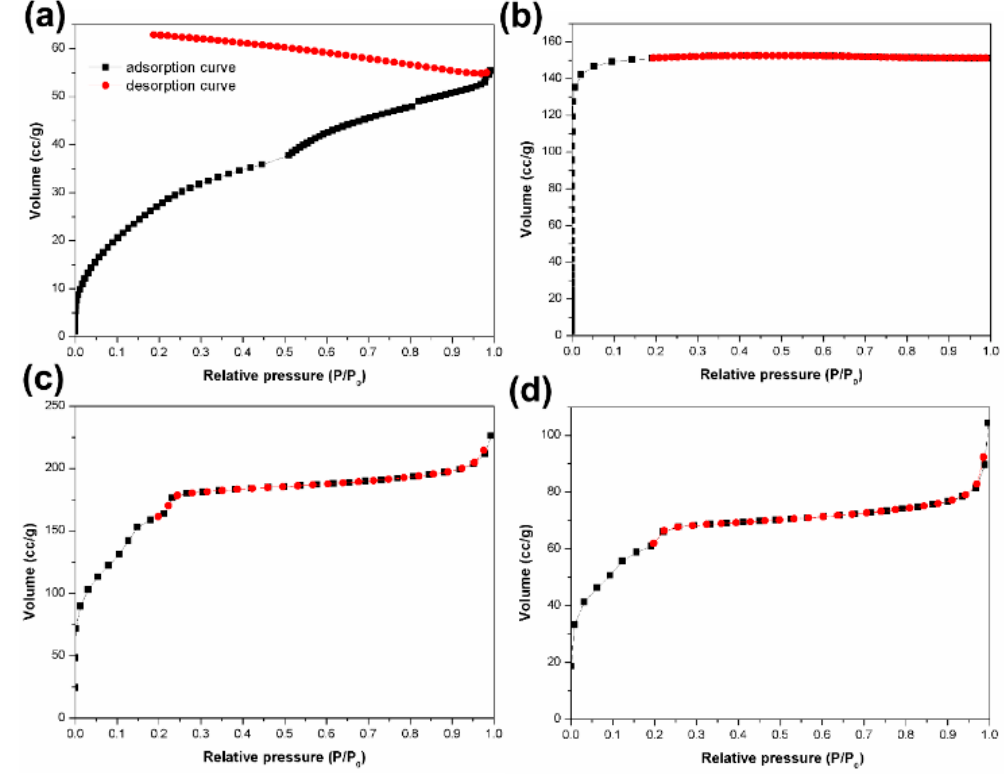
Figure 8. N 2 adsorption isotherms of the ( a ) control and ( b–d ) lignin-based carbon materials in 40 wt % ZnCl 2 solution using ( b ) microwave, ( c ) ultrasound, and ( d ) UV irradiation, respectively.